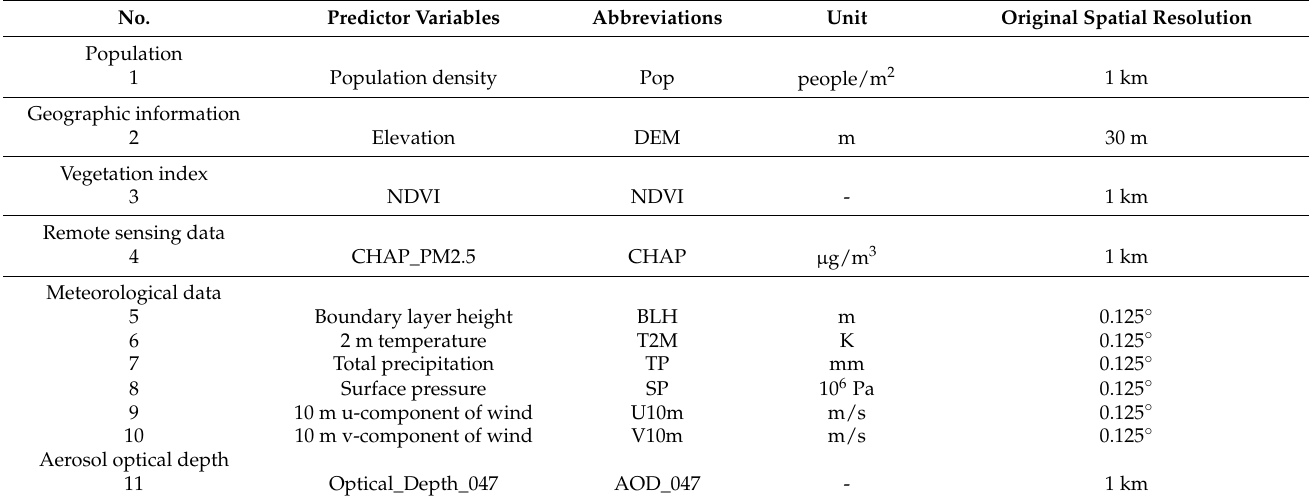
Table 2. Description of the raster predictor variables in the LUR models of